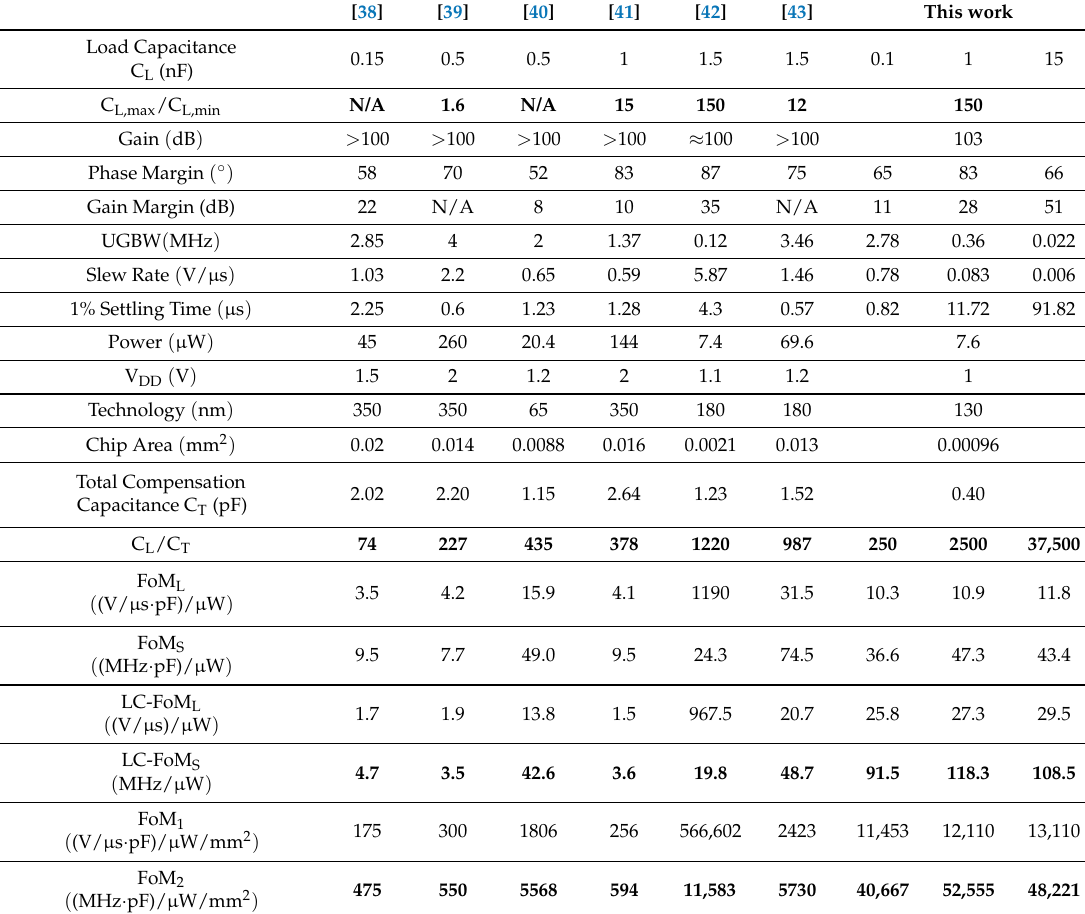
FoM L = ( SlewRate · C L ) /Power FoM S = ( UGBW · C L ) /Power [37]. LC-FoM L = ( SlewRate · C L ) / ( Power · C T ) LC-FoM S = ( UGBW · C L ) / ( Power · C T ) [41]. FoM 1 = ( SlewRate · C L ) / ( Power · ChipArea ) FoM 2 = ( UGBW · C L ) / ( Power · ChipArea )